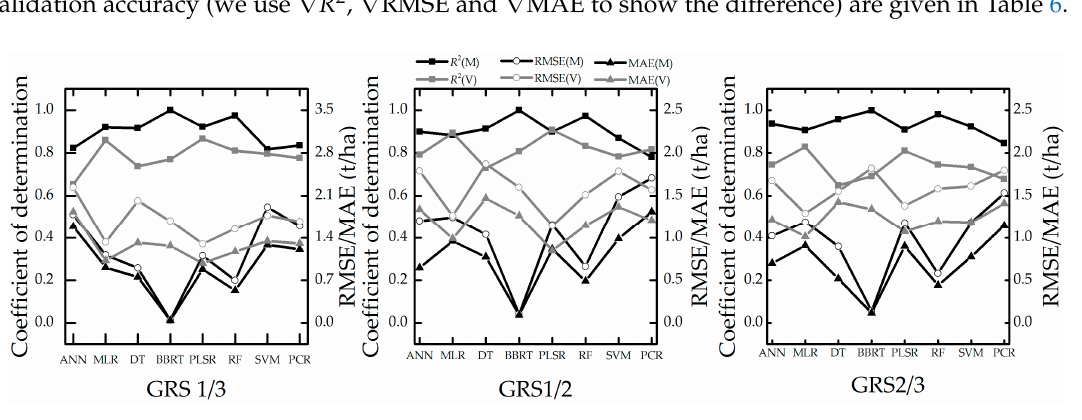
Figure 8. Modeling and validation results for global random sampling (GRS). Table 6. Absolute difference of AGB − GRS modeling and accuracy of validation.